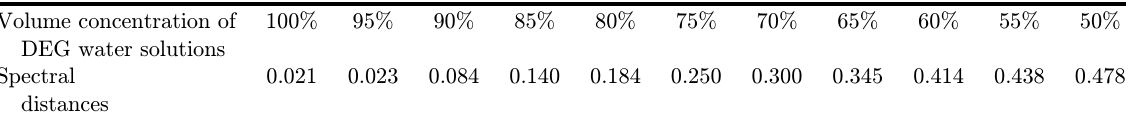
Table 1. Spectral distances of DEG solutions under di®erent concentrations to the group \DEG" in the identi¯cation model. Volume concentration